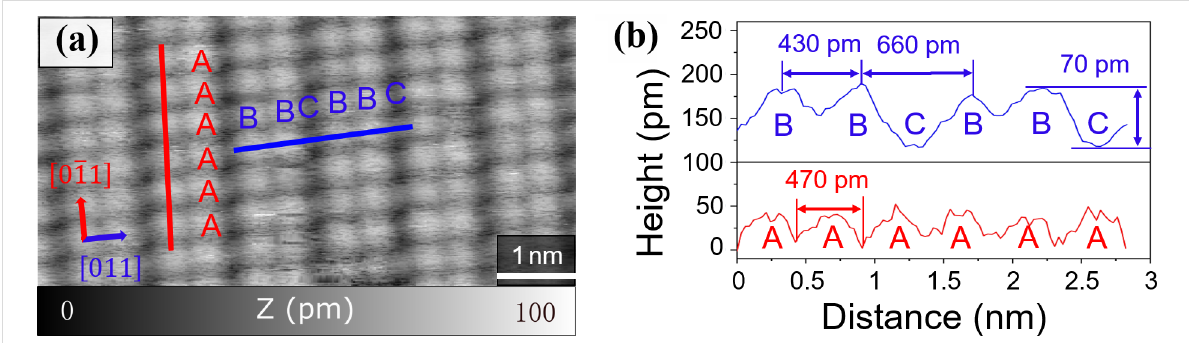
Figure 2: (a) Atomic resolution of a corrugated KBr line structure ( A 2 = 300 pm, Δ f 2 = − 125 Hz, γ = − 1.02 pN·nm 1/2 ). (b) Atomic line profiles of two or- thogonal lattice directions in red (with a single-atom duplication along “AAA”) and in blue (with a triple-atom duplication along “BBC”) indicated in (a),